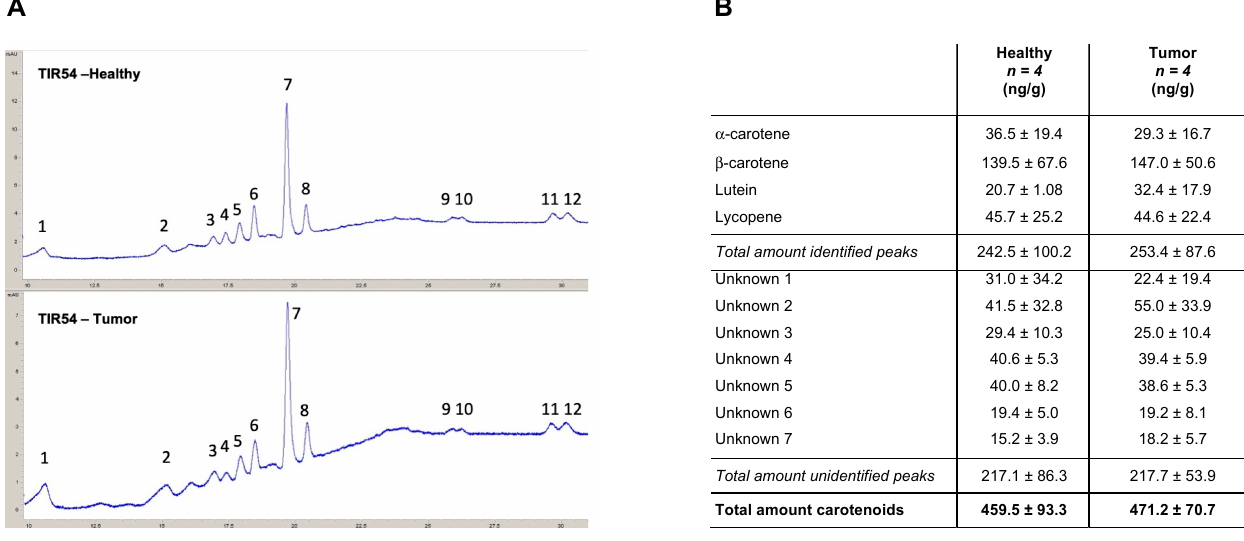
Figure 1. HPLC profiles of carotenoids recorded in the healthy and tumoral thyroid lobes of PTC patients. ( A ) Representative carotenoids HPLC chromatogram: (1) lutein; (2) unknown 1; (3) unknown 2; (4) unknown 3; (5) unknown 4; (6) α -carotene; (7) β -carotene; (8) unknown 5; (9) unknown 6; (10) unknown 7; (11 and 12) lycopene. ( B ) Mean values of α -carotene, β -carotene, lutein, and lycopene concentrations (ng/g of thyroid tissue) quantified in the healthy and pathological lobes of the thyroids derived from four PTC patients (i.e., TIR22, TIR54, TIR77, and TIR94), together with seven unidentified peaks attributable to molecules with absorbances measured at 450 and 472